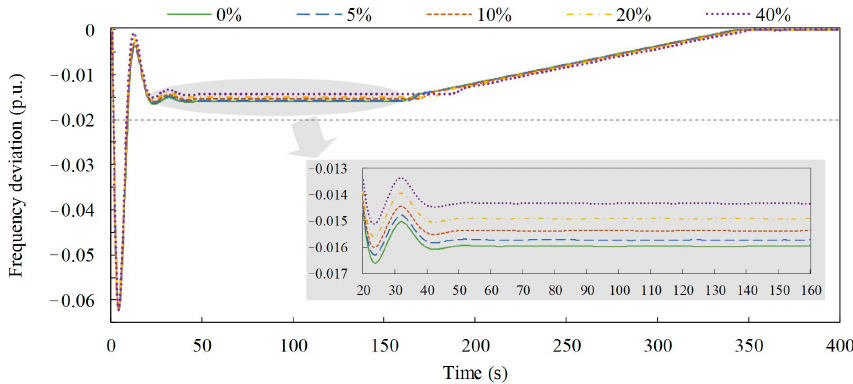
Figure 10. Frequency regulation by the EV aggregator under different regulation preference rates.